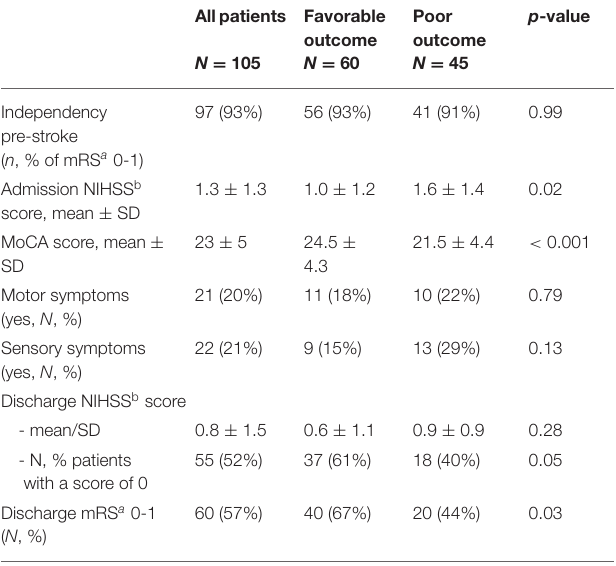
TABLE 2 | Clinical symptoms and scores of the patients of the construction